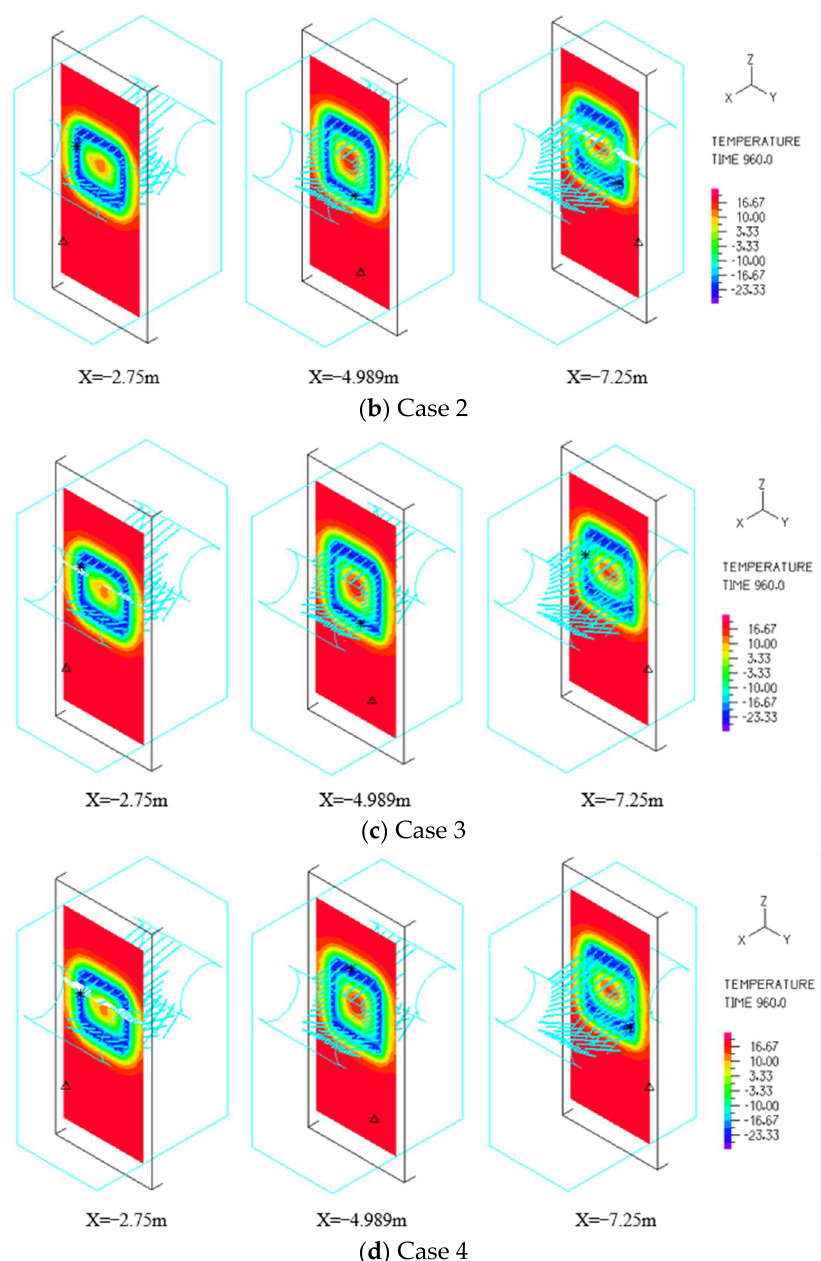
Figure 7. Temperature distribution clouds on each cross-section under different working conditions.